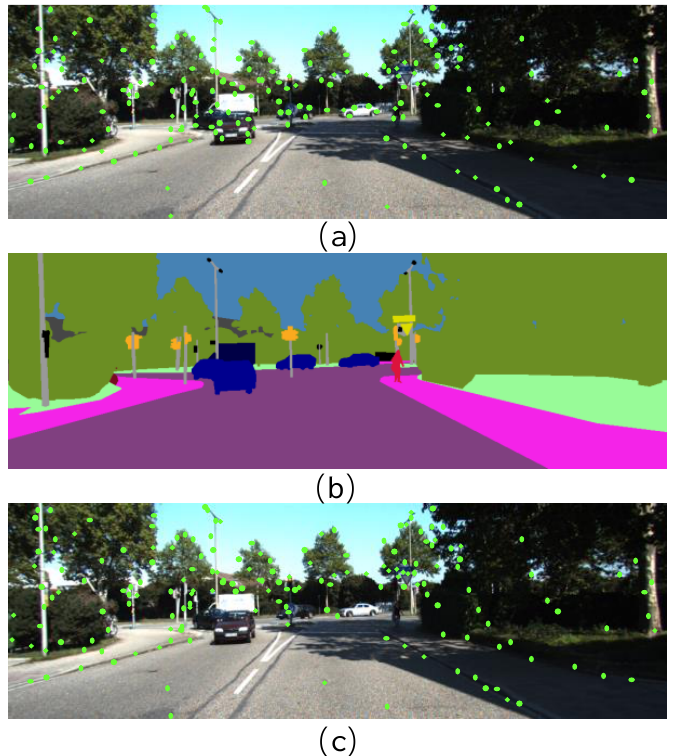
Figure 4. ( a ) Feature point map extracted from the original ORB descriptor; ( b ) Semantic segmentation renderings; ( c ) Feature point map for improved ORB descriptor extraction. After our improvement, the extracted feature points are no longer distributed on dynamic objects but more concentrated on objects with object categories such as poles and traffic lights.